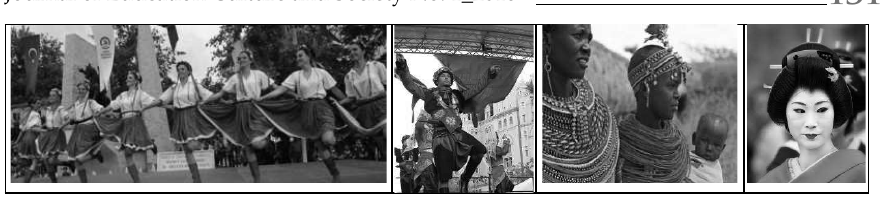
Table 6. The (cid:223) ow chart of the lesson Step Dur. Teacher Behavior Student Behavior Technique (min.)